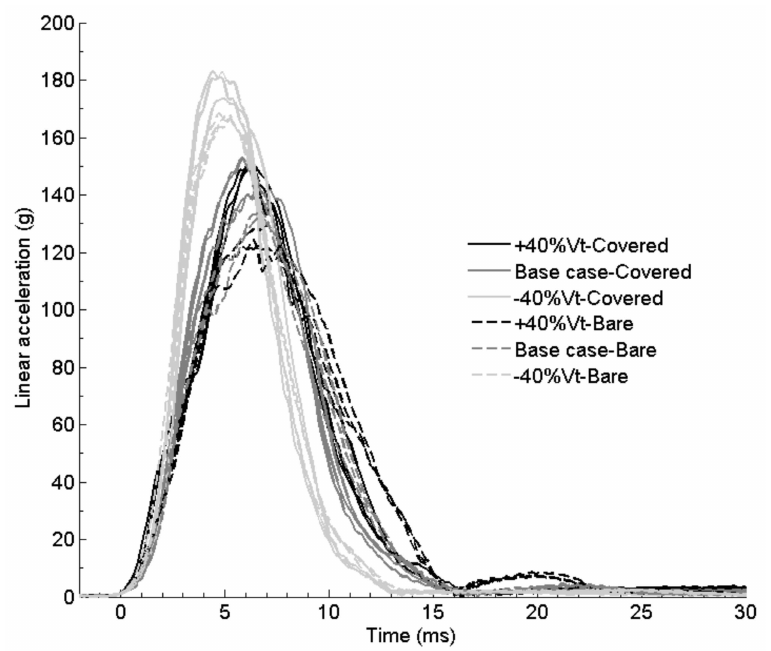
Figure 3. Time-history plot of the resultant linear acceleration for the front impacts. Solid lines correspond to covered headform and dashed lines correspond to bare headform test.